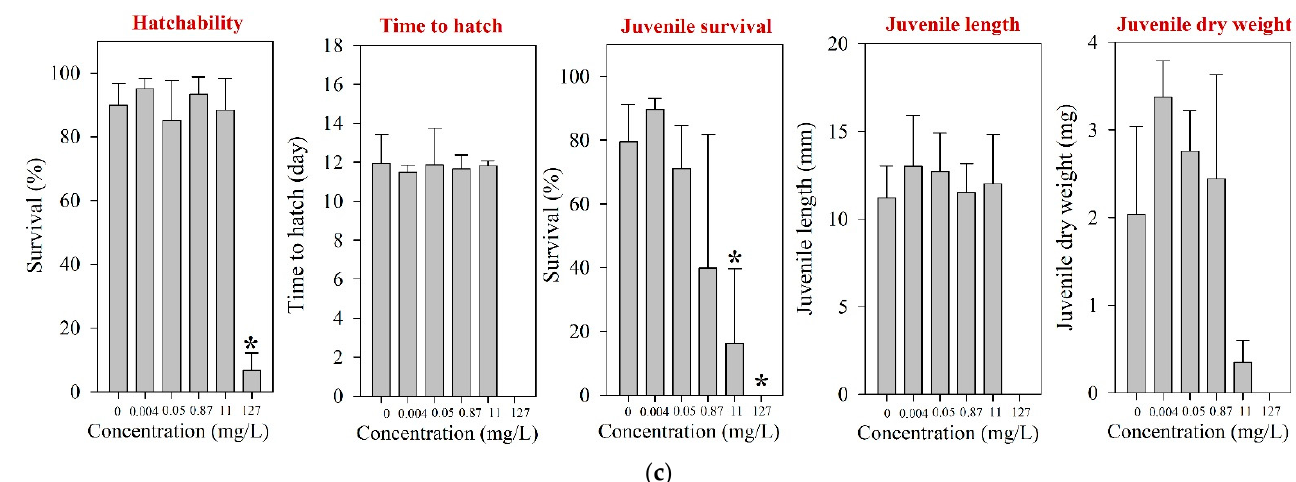
Figure 3. Results of the early life stage test of O. latipes for ( a ) amoxicillin, ( b ) enrofloxacin, and ( c ) neomycin. The results are shown as mean ± standard deviation ( n = 4). Asterisk (*) denotes a significant difference in the observation endpoint from that of the control ( p < 0.05). Monotonous trend was assumed for statistical analysis of hatchability of O. latipes exposed to amoxicillin ( a ).